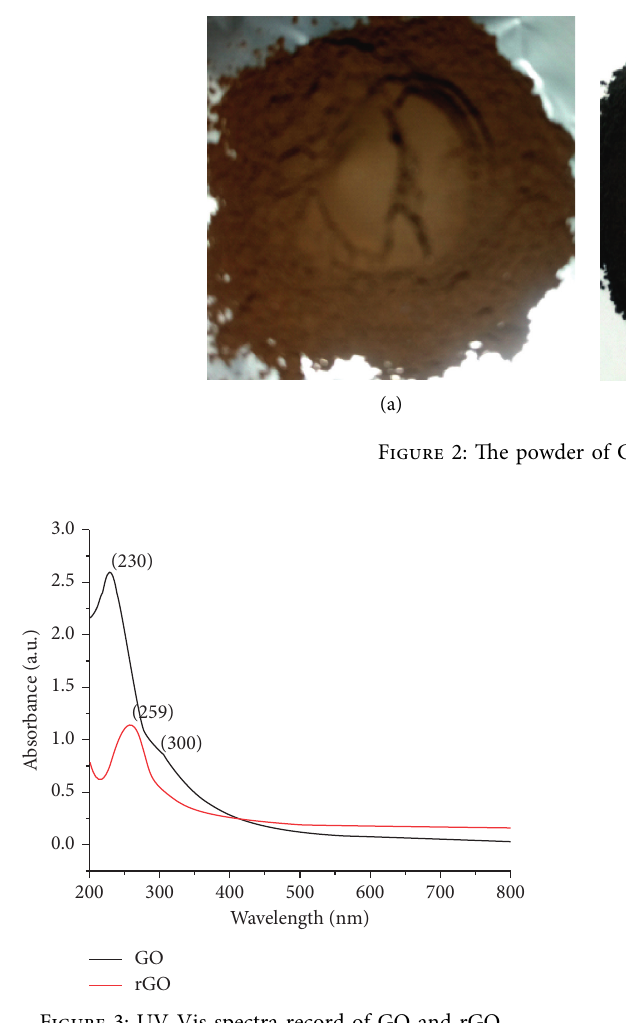
Figure 3: UV-Vis spectra record of GO and rGO.